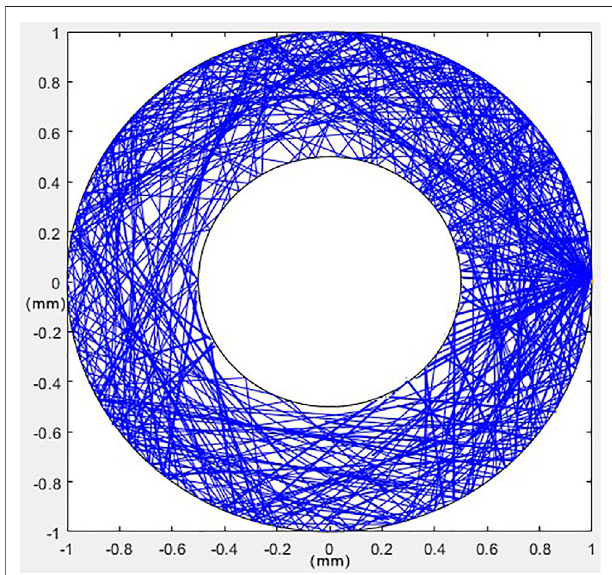
FIGURE 2 | Planar concentric cavity simulation with 1,000